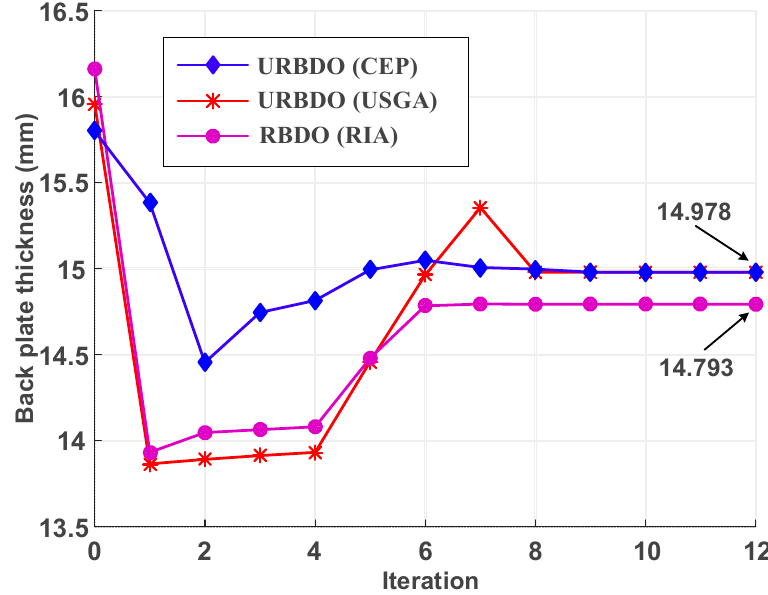
Figure 8. The design history of the brake system problem.